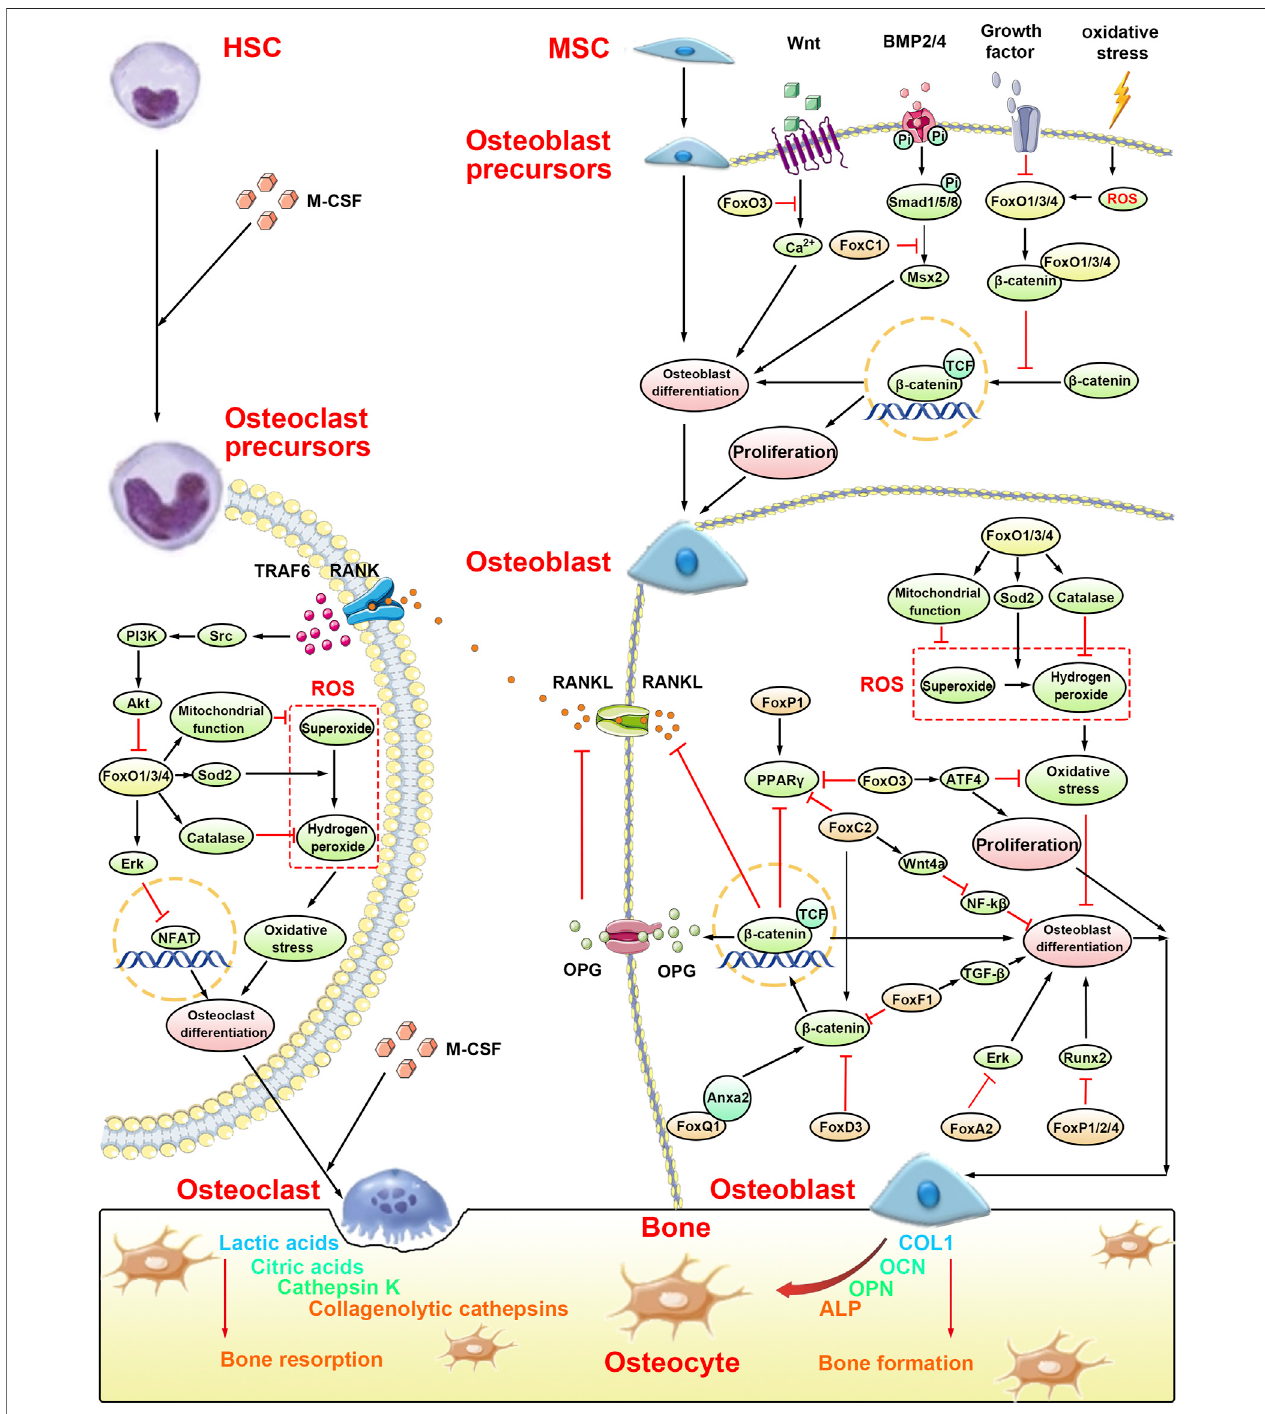
FIGURE 2 | Molecular mechanisms of bone formation and bone resorption in osteoporosis by the Fox family. The occurence of osteoporosis is caused by the imbalanceofboneformation,whichiscausedbyosteoblasts,andboneresorption,whichiscausedbyosteoclasts.Osteoblastprecursors,originatedfromMSC,willbe suppressed in osteoblast differentiation by FoxC1 and FoxO1/3/4. Meanwhile, FoxO1/3/4 can suppress the proliferation of osteoblast precursors by binding with β -catenin. In osteoblast, FoxA2, FoxC2, FoxD3, and FoxP1/2/4 suppress osteoblast differentiation. However, FoxO1/3/4 and FoxQ1 promote osteoblast differentiation. Interestingly,FoxF1 notonlysuppressosteoblastdifferentiationbytheWnt/ β -cateninsignaling pathwaybut alsopromoteosteoblastdifferentiation bythe TGF- β signaling pathway. Furthermore, FoxO3 can promote proliferation of osteoblast precursors by activating ATF4. Osteoclast precursors, originated from HSC, will be suppressed in osteoclast differentiation by FoxO1/3/4 through the Erk signaling pathway and ROS-dependent pathway.